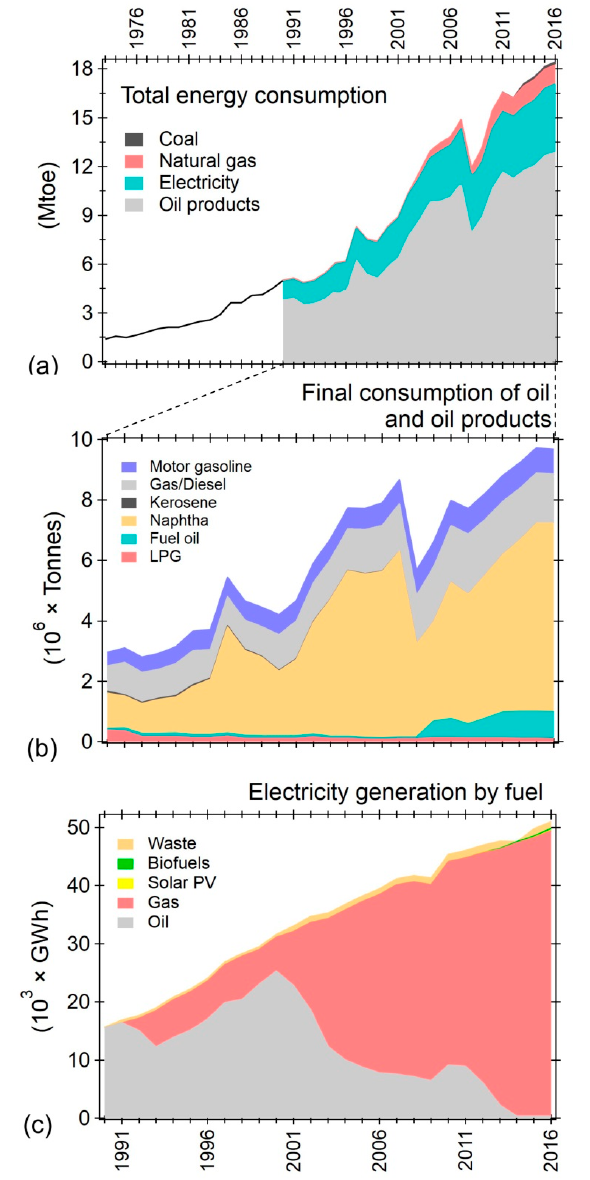
Figure 8. Historical consumption of energy in Singapore. Panel ( a ) shows the total energy consumption by source in megatons of oil equivalent (Mtoe). Oil products and electricity have been the two main sources of energy; panels ( b ) and ( c ) show their consumption from 1990 to 2016 by type of fuel and fuel used for its generation, respectively. Data were extracted from the International Energy Agency (IEA) World Energy Balances 2018 (https://www.iea.org).